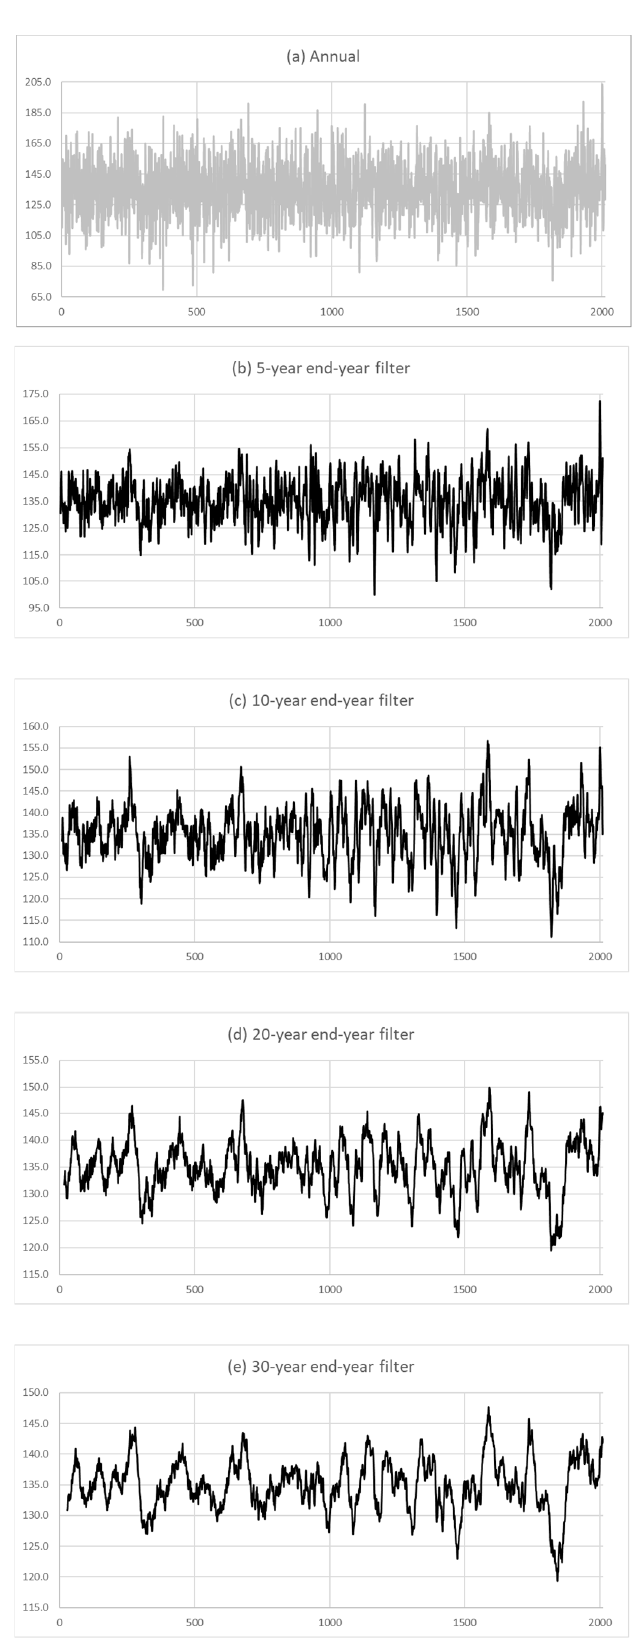
Figure 5. Reconstructed Adige/Etsch (Branzoll)—Year versus Flowrate (m 3 /s) from 0 to 2012 AD